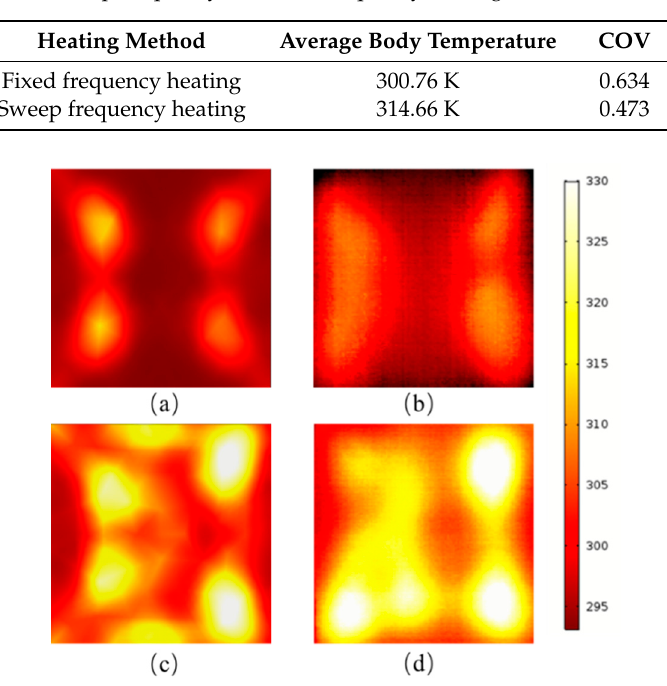
Figure 9. The electric field distribution at different frequencies.